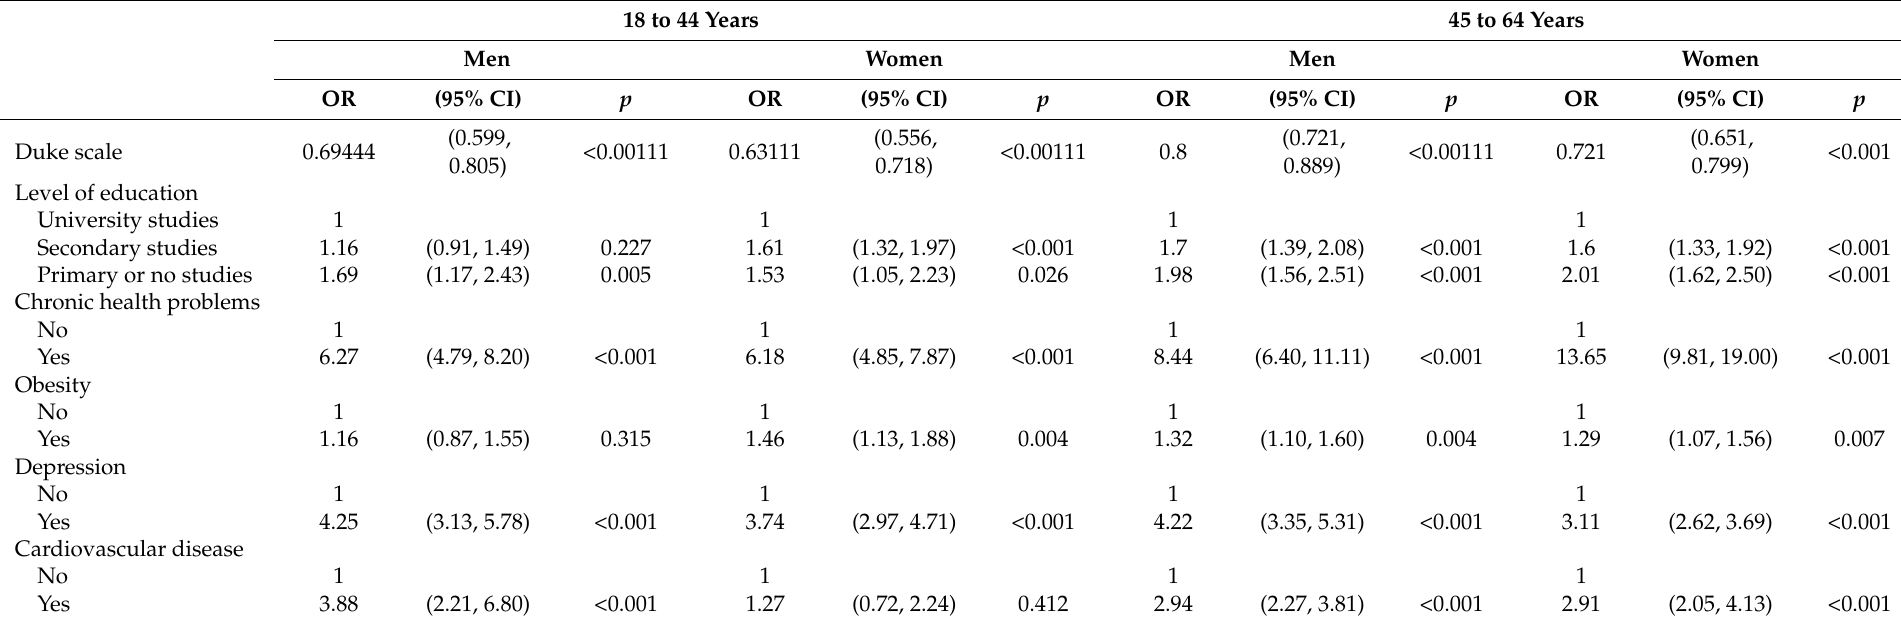
Table 3. Risk of presenting poor self-perceived health based on Duke functional social support scale by age group and sex. Adult men and women. 2017 Spanish National Health Survey. 18 to 44 Years 45 to 64 Years Men Women Men